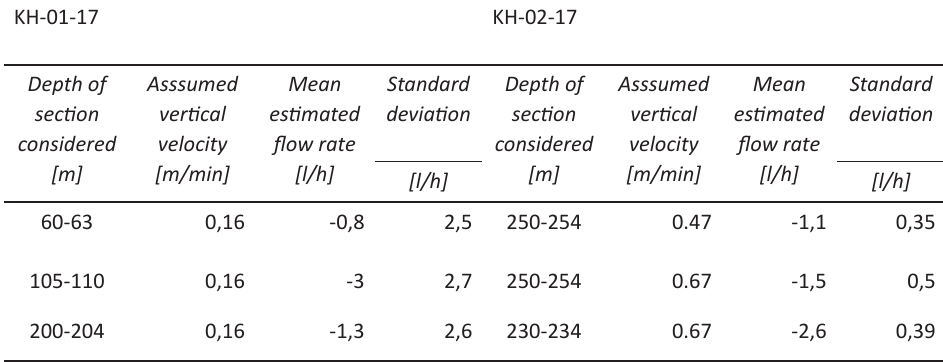
Table 3. Estimated groundwater flow and their standard deviations for sections without visible fractures in boreholes KH-01-17 and KH-02-17. As the vertical flow for the section at 250-254 m depth in KH-02-17 is uncertain, two results with two different values for vertical flow are